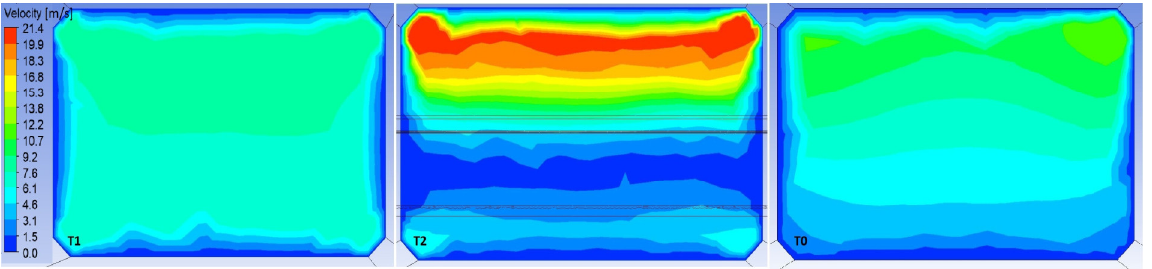
Figure 10. Streamlines; CFD model with a beam size of 288 mm without deflectors.